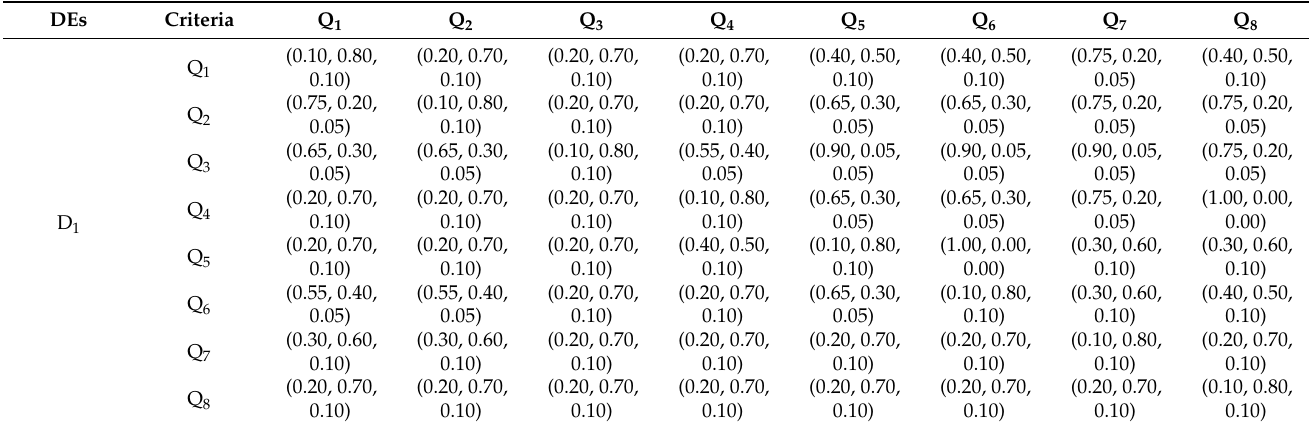
Table 8. The intuitionistic fuzzy direct-influence